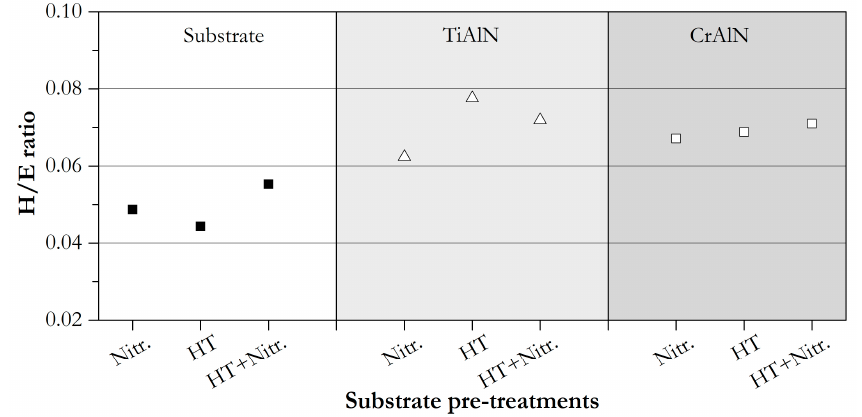
Figure 7. H / E ratio of the substrate after the pre-treatments and of the coatings deposited on the different substrates.